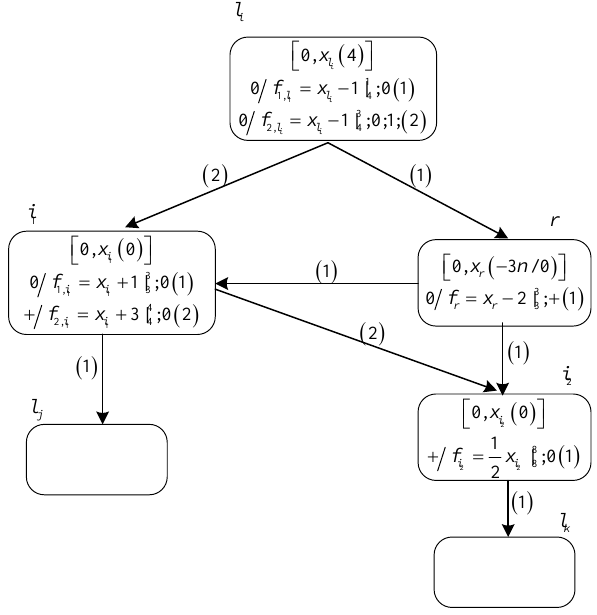
Figure 4. The SUB module in system 1 Π .